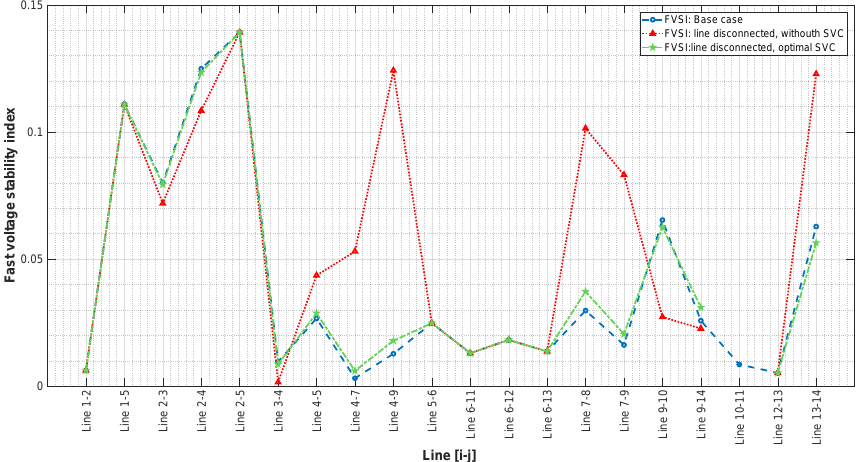
Figure 9. First study case: FVSIs before/after contingencies and with SVC compensation, when the line that contains the node for the optimal solution is disconnected.